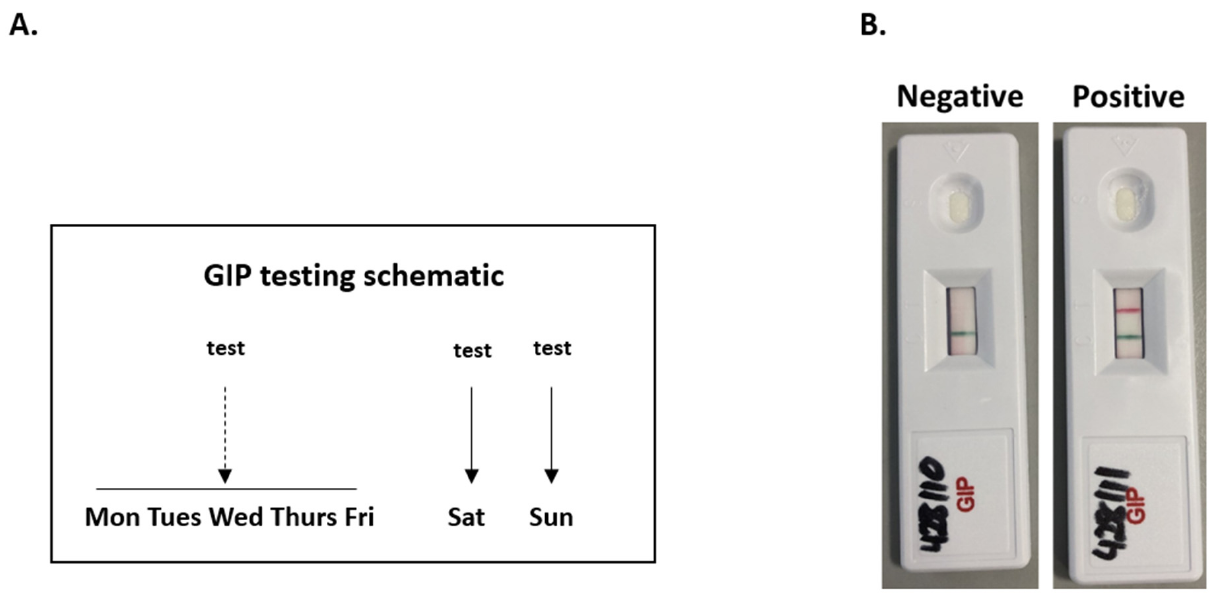
Figure 4. ( A ) Urine GIP testing schematic. Patients provided three urine samples in total—one from during the week and two from the weekend. ( B ) Example urine GIP immunochromatographic tests. If present, GIPs in the sample interact with monoclonal antibodies A1 and G12 on the test strip, producing a red line in the test zone [21]. An internal control generates a green line which indicates correct test performance [21].